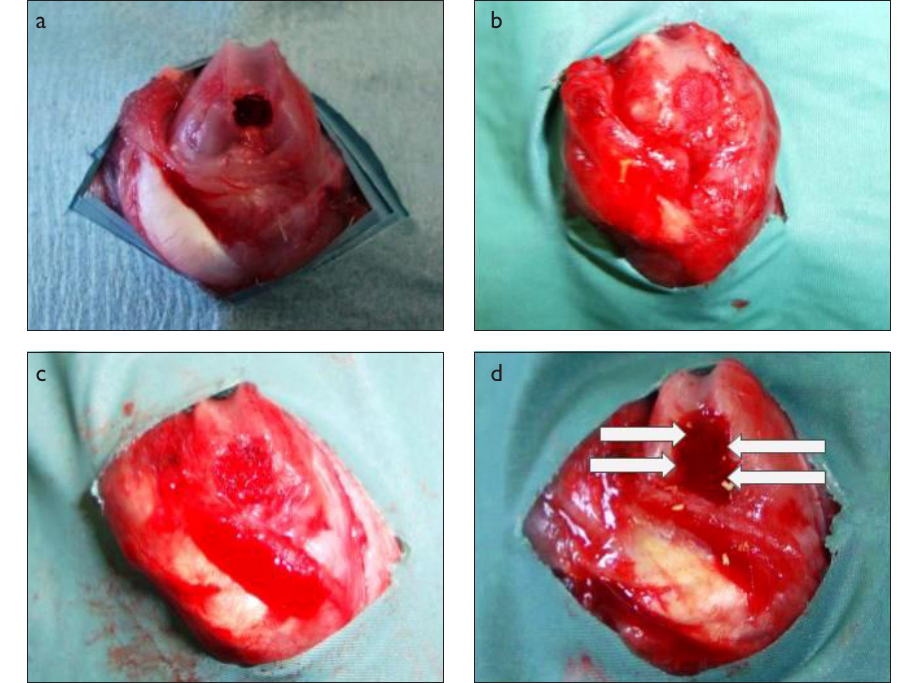
Figure 1. a-d. a) Knee with an osteochondral defect. b) Knee with a biomimetic scaffold. c) Knee with a chondral scaffold. d) Knee subjected to